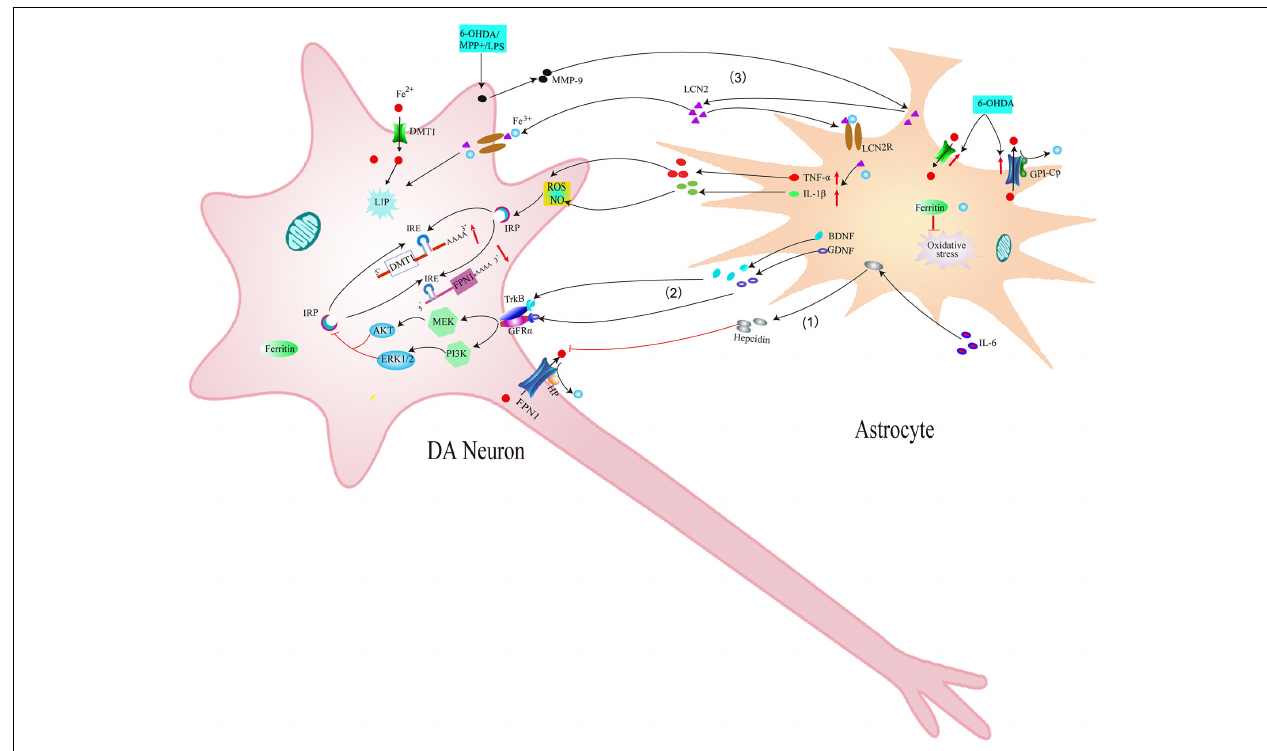
FIGURE 4 | Schematic illustration showing the effects of astrocytes on iron accumulation in dopaminergic neurons in PD. (1) IL-6 could promote astrocytes to release hepcidin, which then prevents FPN1-mediated iron release from DA neurons. (2) BDNF and GDNF secreted by activated astrocytes can inhibit IRP via acting on their receptors, thus down-regulating the expression of DMT1 and reducing iron accumulation in DA neurons. (3) MMP-9 released by damaged DA neurons could lead to upregulation and release of LCN2. LCN2 then activates astrocytes to release TNF- α and IL-1 β , which up-regulates DMT1 and down-regulates FPN1 in DA neurons. Released LCN2 might also induce direct neurotoxicity via excessive iron delivery into DA neurons by binding to LCN2